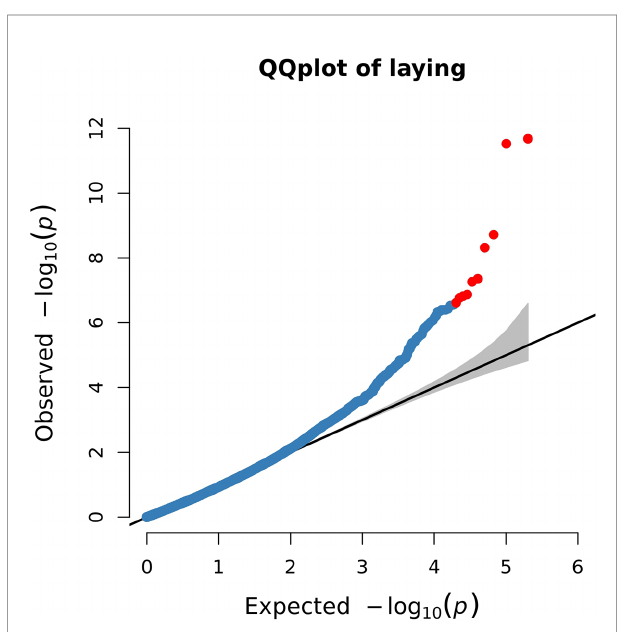
FIGURE 4 | Quantile – quantile (Q-Q) plot of genome-wide association results for egg production. The blue points represent SNPs, and the red points represent the most signi fi cant SNPs.